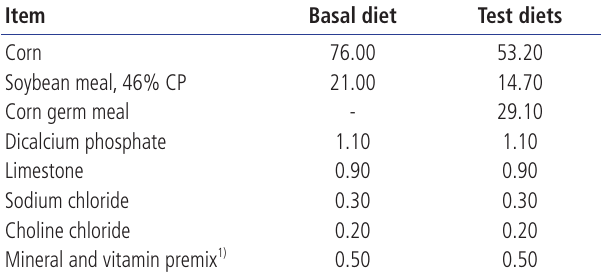
Table 3. Ingredient compositions of the experimental diets (%, as-fed